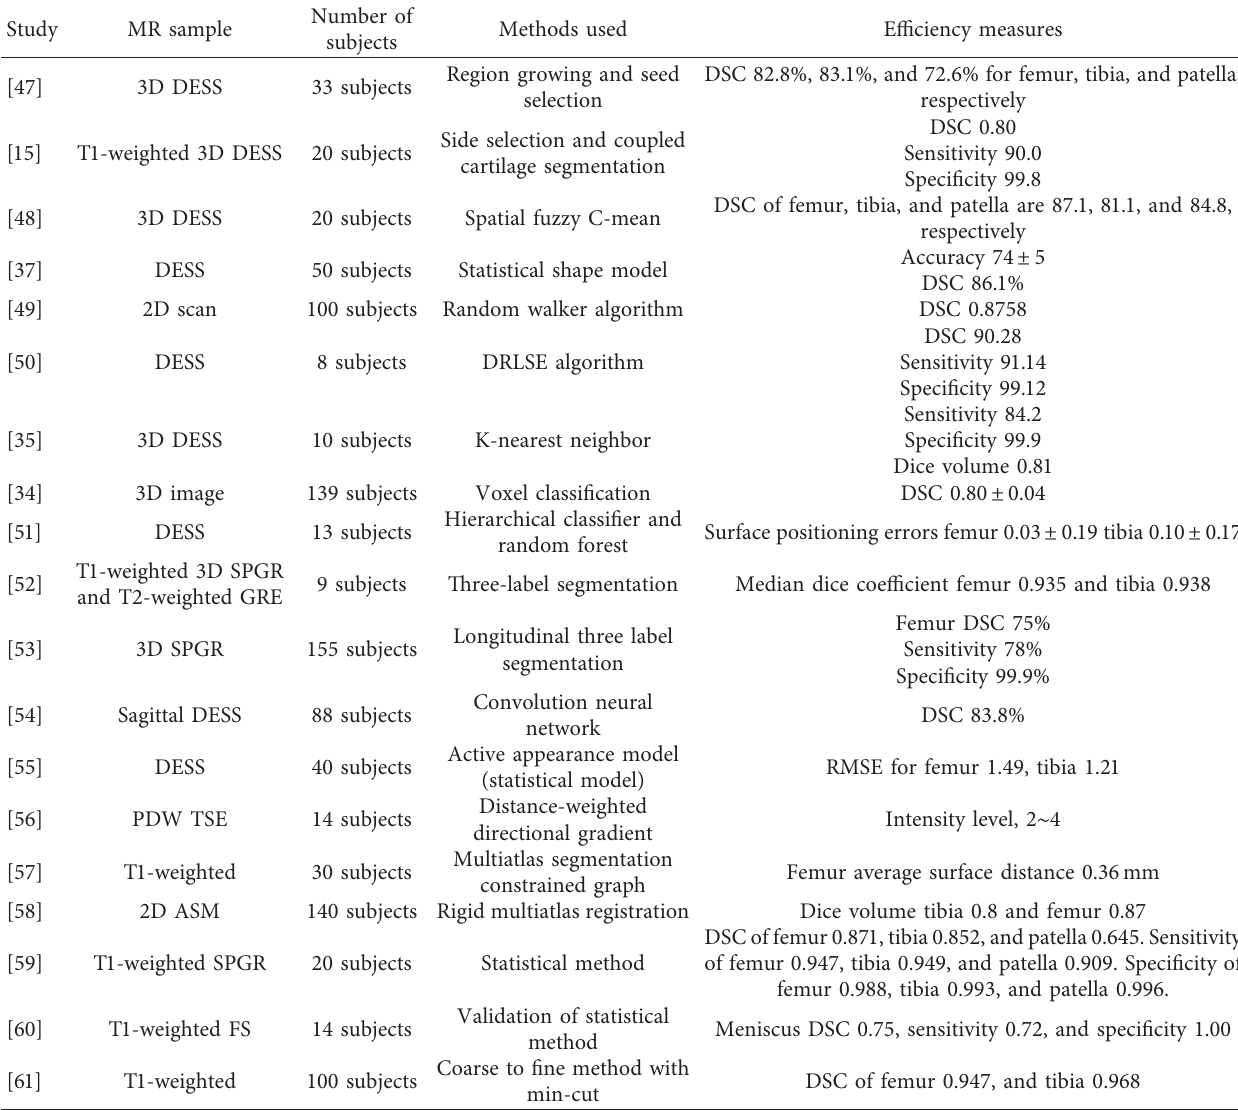
Table 1: Automated segmentation approaches.